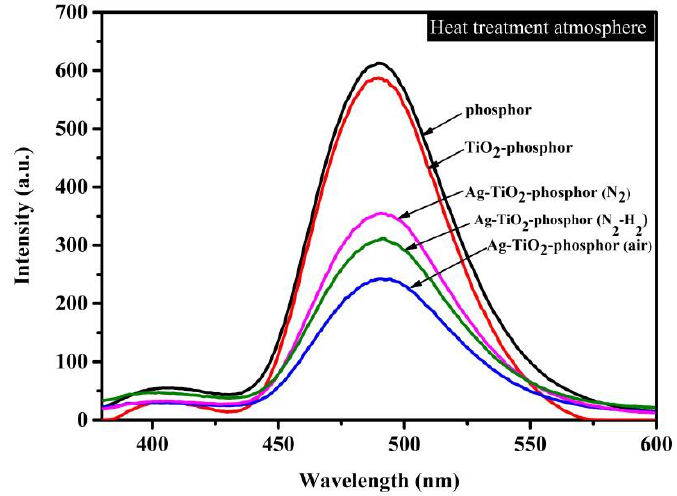
Figure 6. PL spectra for Ag-TiO 2 /Sr 4 Al 14 O 25 :Eu 2+ ,Dy 3+ photocatalyst/phosphor beads calcined in air, N 2 , and N 2 -H 2 atmospheres.